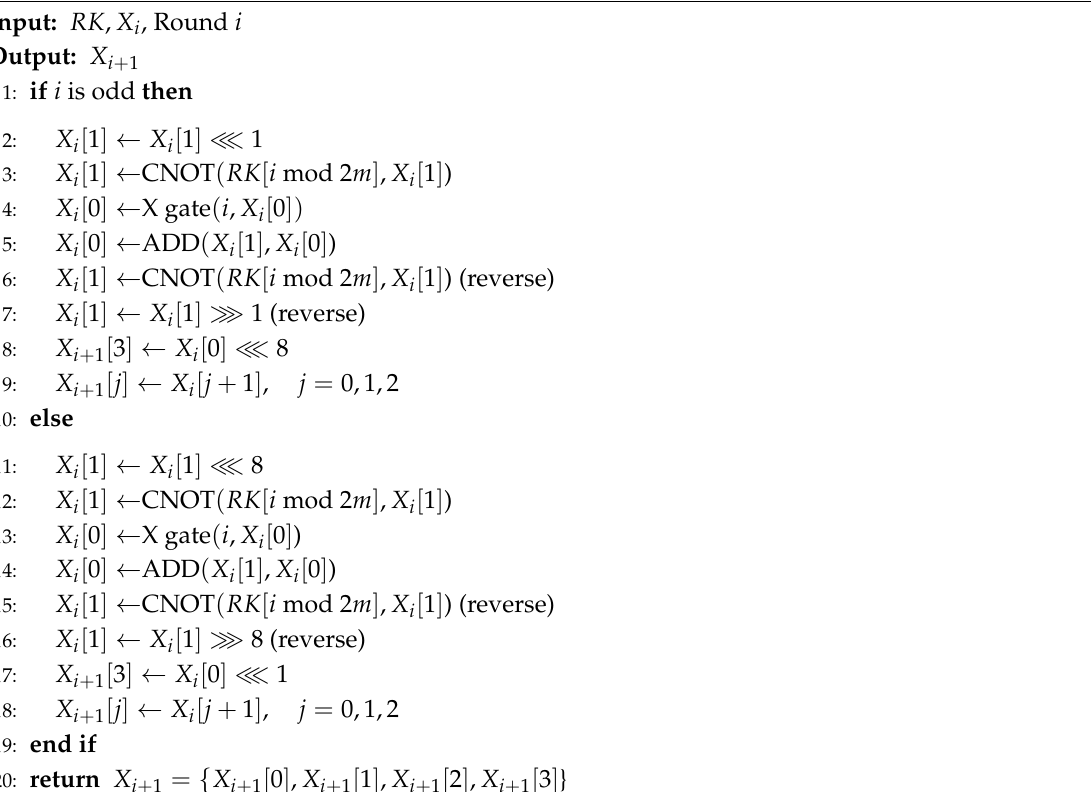
Algorithm 9 Round function of CHAM.